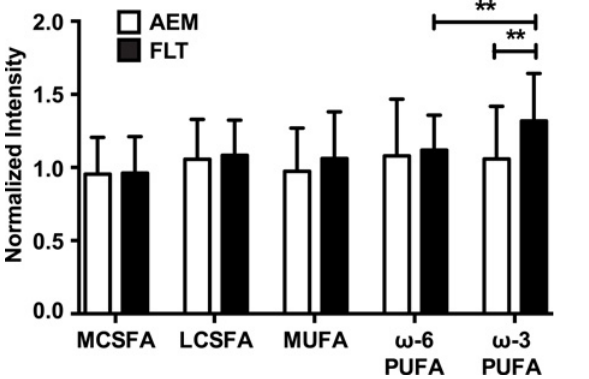
Fig 6. Increased ω -3 polyunsaturated fatty acid concentration following spaceflight. Mass spectrometry-based metabolomics was performed and spectra corresponding to both saturated and unsaturated fatty acids were identified and chromatographic peaks quantified. Mann-Whitney analysis of results from n = 5 mice per group showed a significant increase in levels of ω -3 PUFAs in spaceflight mice as compared with AEM controls. ** P < 0.01; data are mean ±